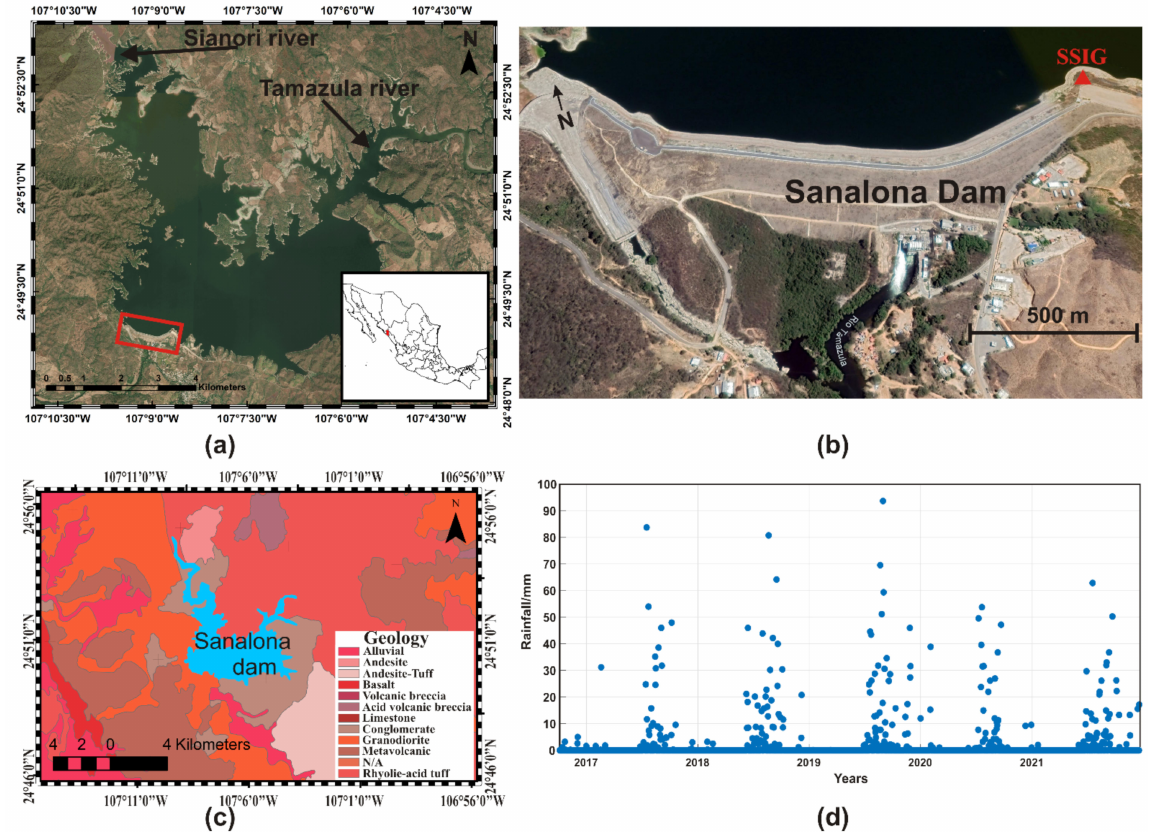
Figure 1. Location of the Sanalona Dam (red rectangle) taken from Google Earth: ( a ) general location of the Sanalona Dam in the Tamazula and Sianori rivers; ( b ) detailed image of the crest of the Sanalona Dam. The red triangle is the location of the GPS station, SSIG; ( c ) geological setting of the Sanalona dam; ( d ) hydrological cycle of the study area. The blue dots represent the rainfall measurements in